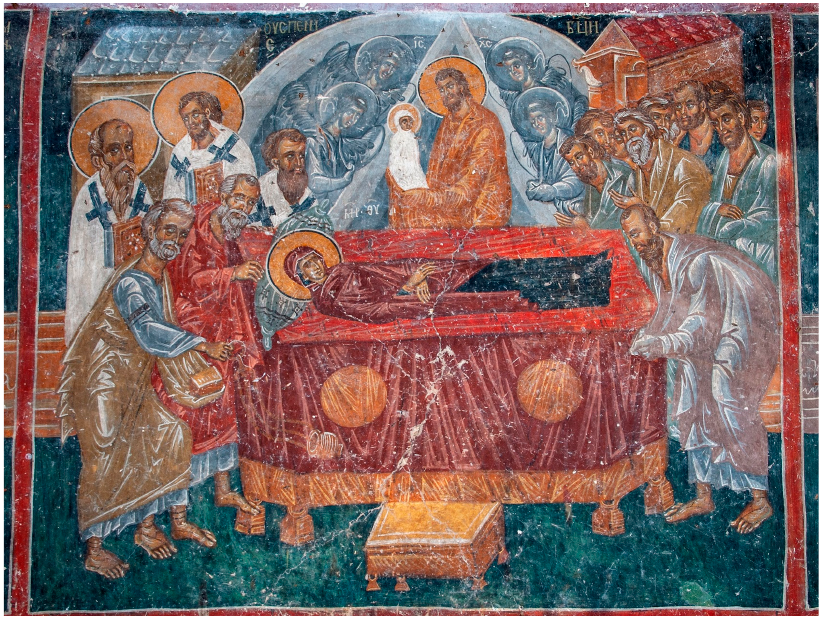
Figure 6. Dormition of the Theotokos , wall painting, 14th century, Church of St. Peter in Berende, Bulgaria. (Photo credit: Angel Yordanov, TerraByzantica ).